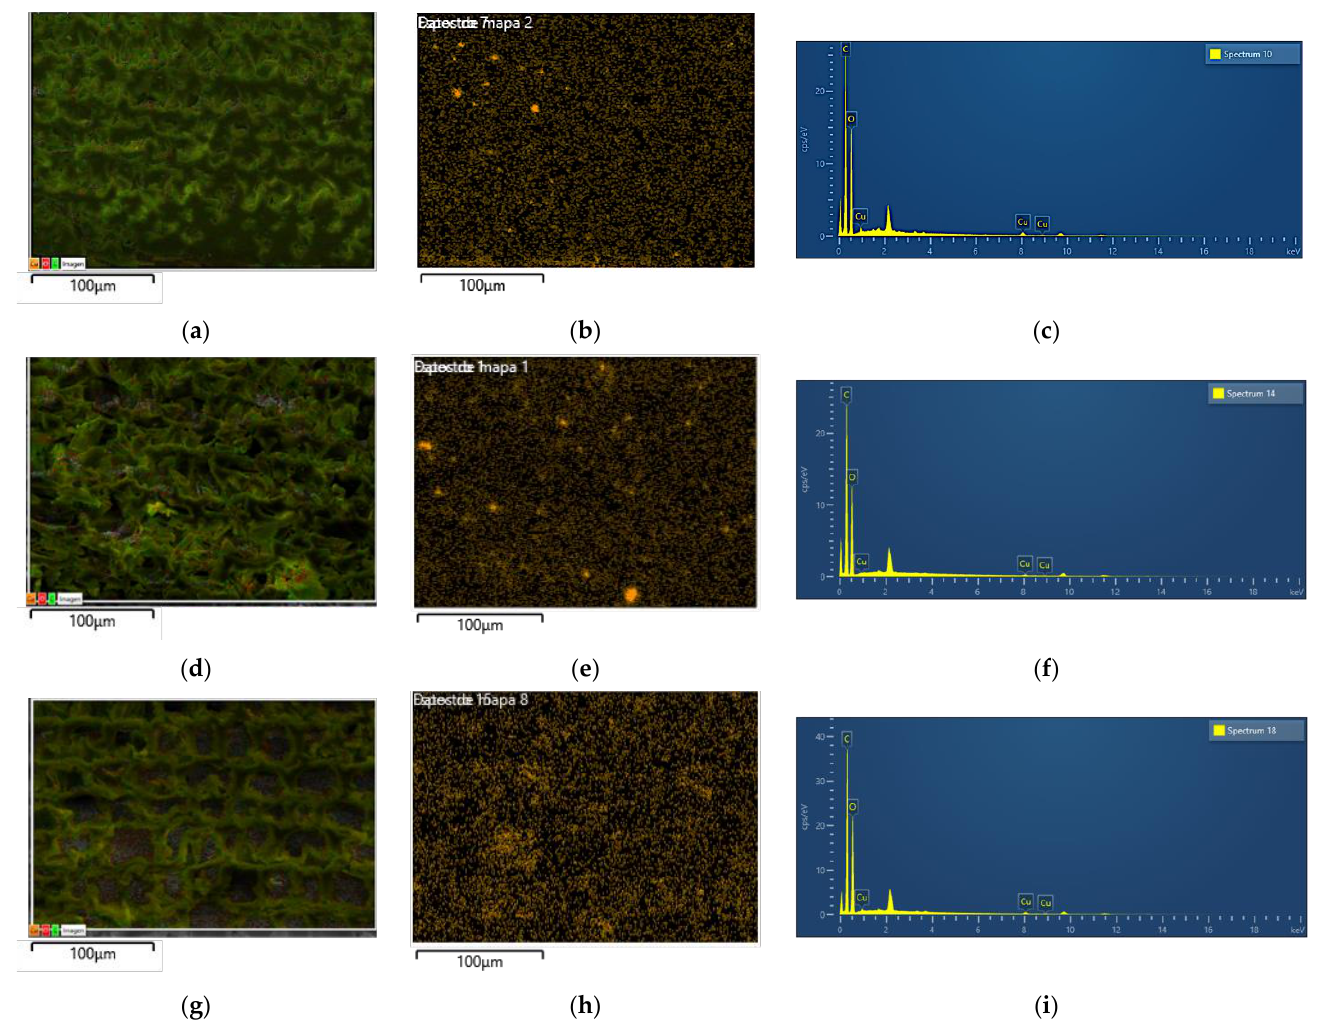
Figure 3. SEM-EDS map for copper of ( a , b ) K1-treated wood, ( d , e ) K2-treated wood and ( g , h ) micronized-copper-treated wood. EDS spectrum of K1 ( c ), K2 ( f ) and M ( i ).